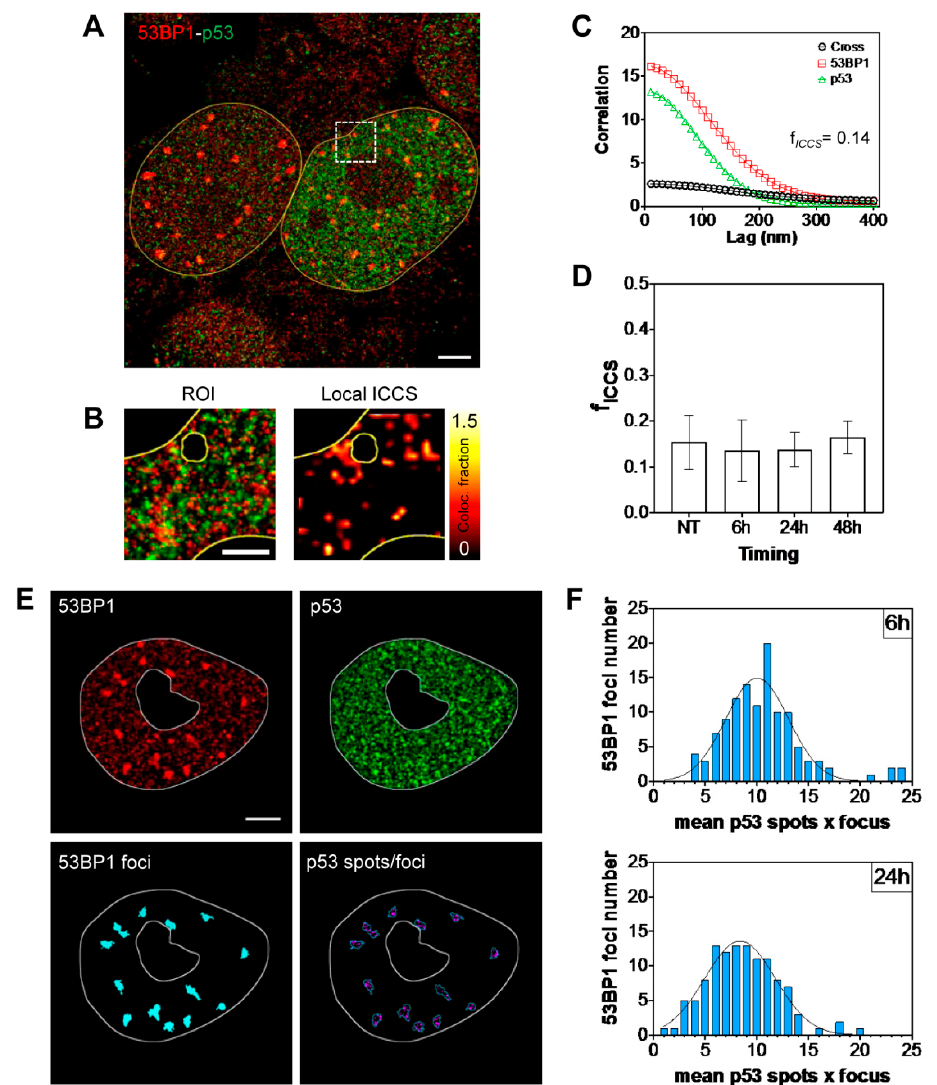
Figure 7. Analysis of single molecule colocalization between 53BP1 and p53. Analysis of representa- tive dSTORM images of MCF10A nuclei acquired upon labeling of ( A , E ) 53BP1 (red) and p53 (green). ( B ) Shown are (from left to right) the dual-color STORM image ROI at different spatial resolutions (10 nm and 50 nm) and the map of the colocalized fraction recovered by local ICCS. ( C ) ROI spatial correlation functions recovered by ICCS. ( D ) Colocalized fraction (fICCS) extracted from ICCS analy- sis at different timepoints. (data are mean ± s.d. of the mean values of fICCS calculated on each cell of NT, 6 h, 24 h, and 48 h; n = 50). The ICCS plot shows the cross-correlation function (black squares) and the red (red circles) and green (green triangles) channel autocorrelation functions along with the corresponding fits (solid lines). ( E ) A.M.I.CO image analysis of p53 spot distribution at 53BP1 foci (cyan) on representative dual color dSTORM image of MCF10A nucleus. ( F ) Total distribution of the number of 53BP1 foci containing the number of p53 spots at 6 h and 24 h. Scale bar: 3 µ m. Scale bar ROI: 1 µ m.